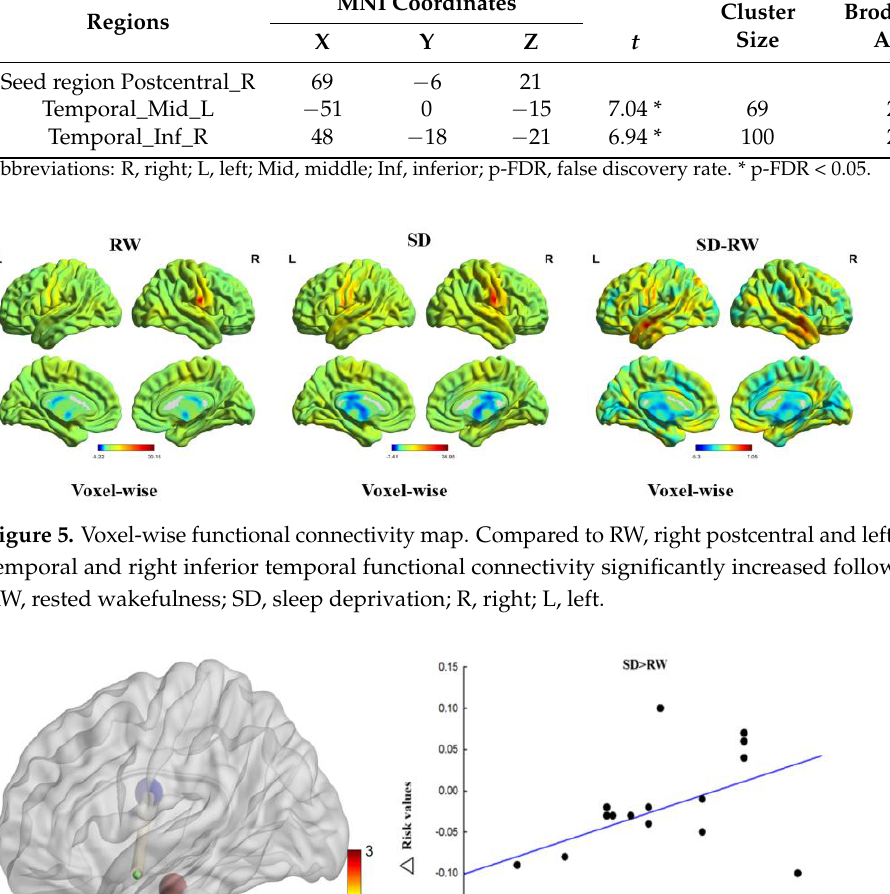
Table 3. Altered right Postcentral functional connectivity following sleep deprivation.